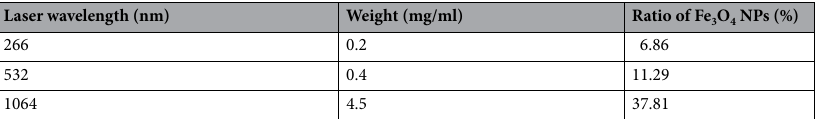
Table 6. Optimal values of Fe 3 O 4 NPs concentration in different wavelengths and liquid at a laser fluence of 28 J/cm 2 .